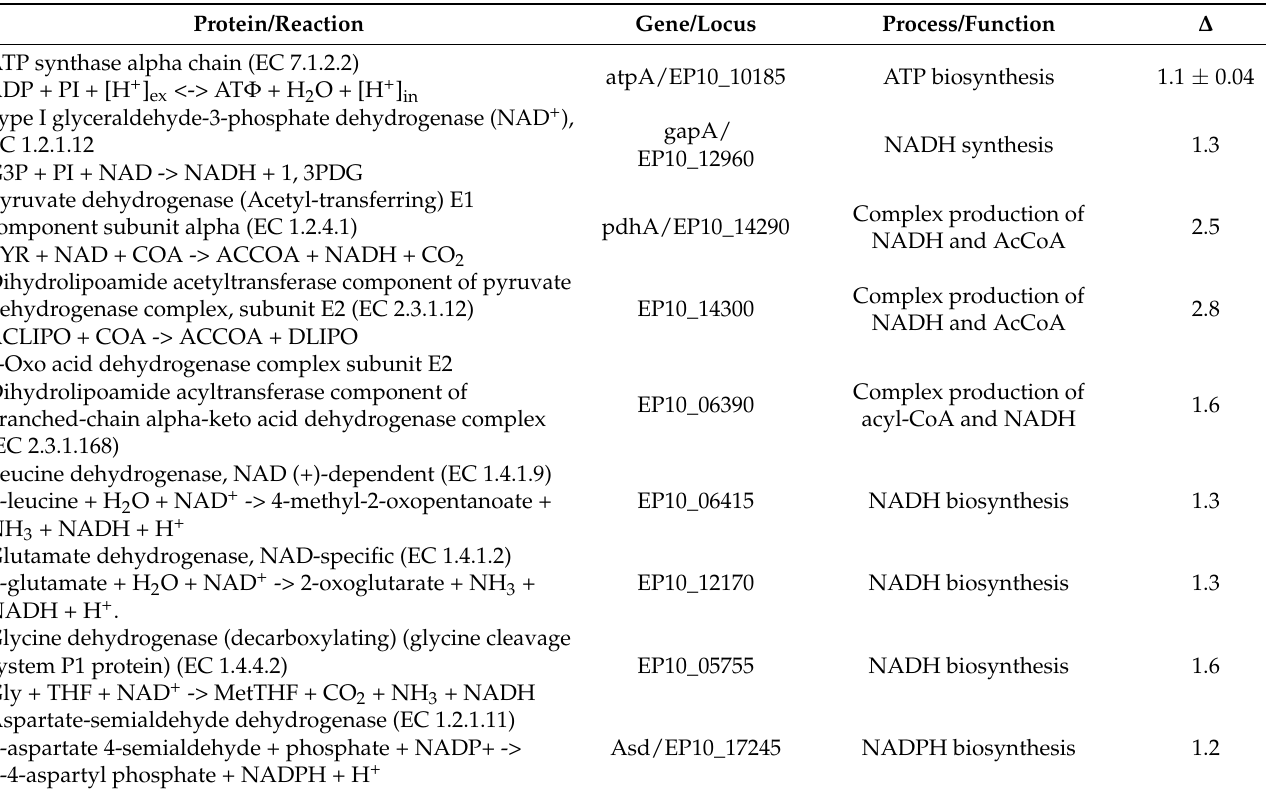
Table 4. The identified proteins significantly upregulated in the proteomic profile of G. icigianus at 10 min after the end of THz